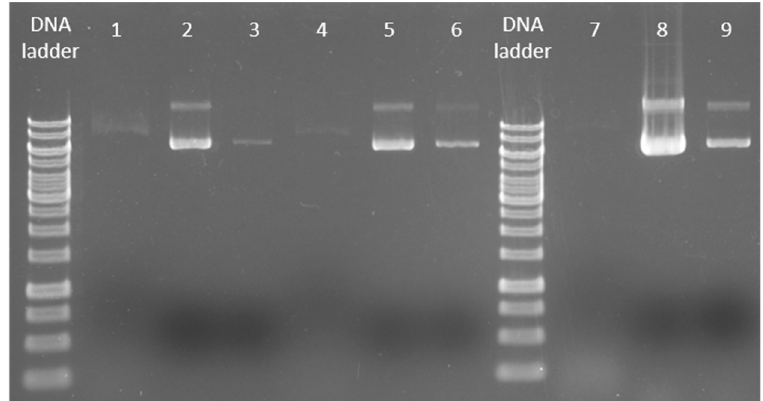
Figure 7. DNA binding capacity of the MnFe 2 O 4 MNPs.